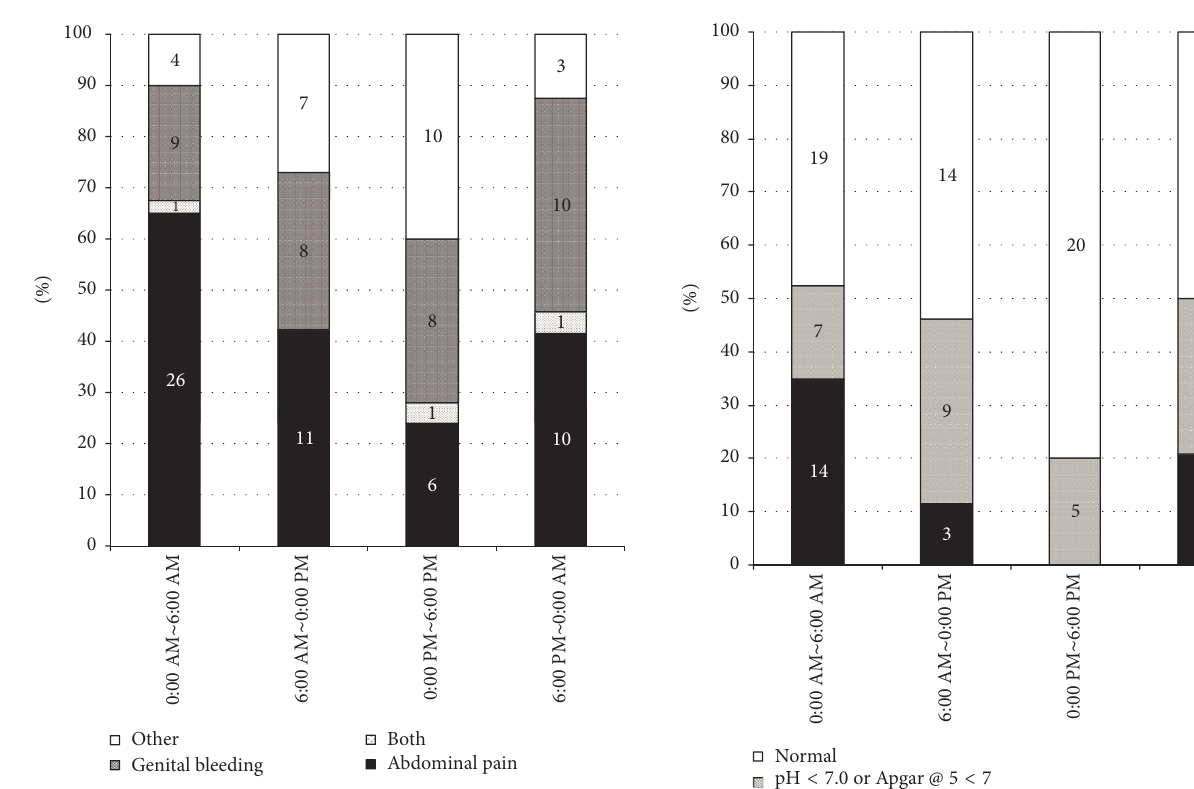
Figure 1: Circadian pattern of onset of disease based on initial symptoms. Initial symptoms included abdominal pain (white), vaginal bleeding (striped), abdominal pain and bleeding (dark), or others (gray). Comparisons of incidence of symptom-oriented diseaseonsetamonggroupsforthefour6-hourintervalsinregardto placental abruption were made using 𝜒 2 tests followed by the Steel- Dwass test for multiple comparisons. A higher level of abdominal pain from 0:00 AM to 6:00 AM was detected when compared with 0:00 PM to 6:00 PM ( 𝑝 < 0.01 ).